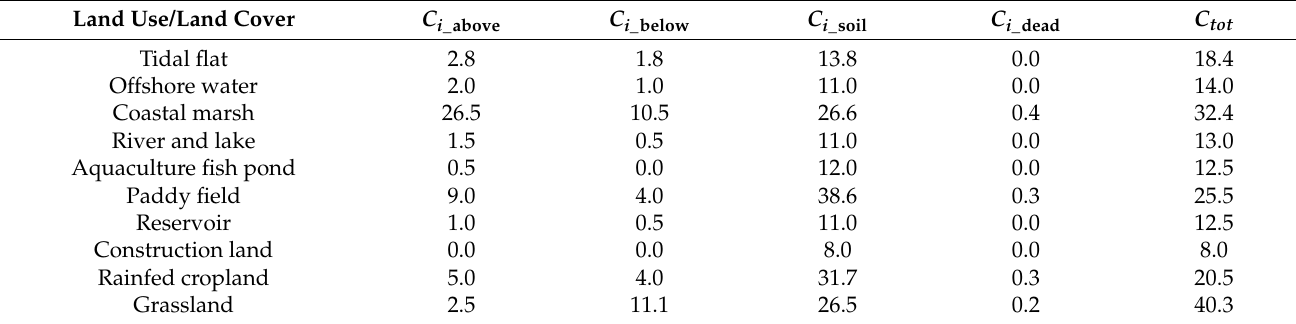
Table 3. Carbon density of the land use/land cover types in the Shanghai coastal area (unit: Mg/ha). Land Use/Land